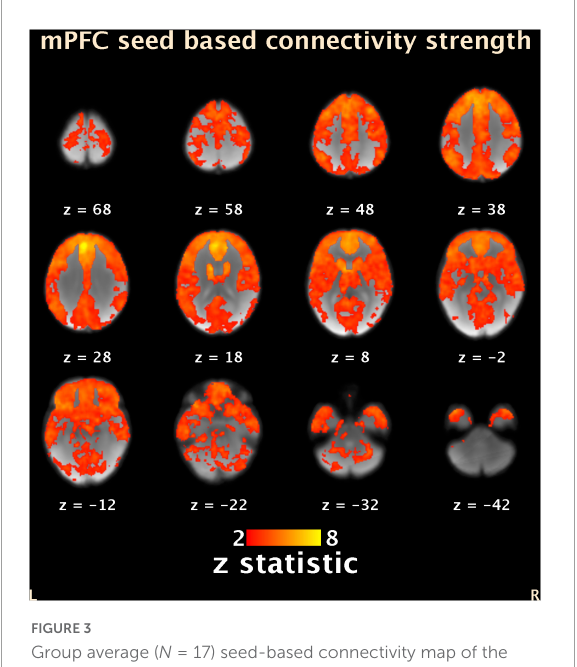
FIGURE3 Group average ( N = 17) seed-based connectivity map of the mPFC (-6, 44, 28). Results are masked with the same gray matter mask as for the ReHo analyses. Locations of the axial slices are given according to MNI space. Color bar represents Z-scores. L, left; R, right; mPFC, medial prefrontal cortex; ReHo, regional homogeneity. MNI, Montreal Neurological Institute.